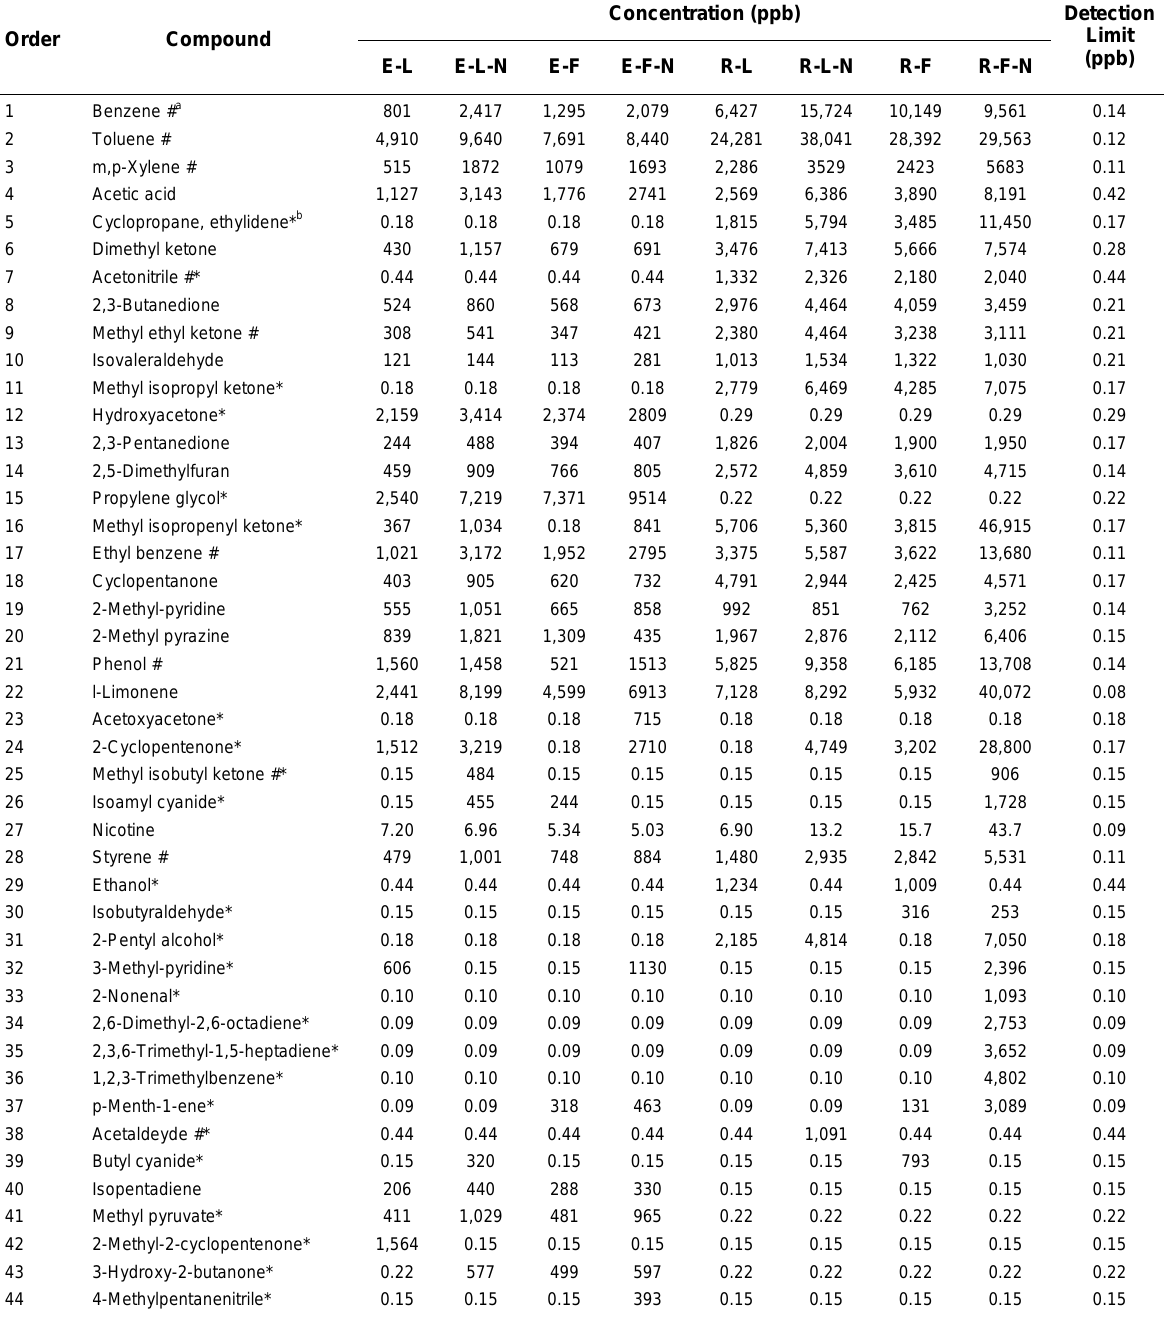
Concentration of Nicotine and VOCs Released in the Form of MSS from Different Brands of Cigarettes with Eight Different